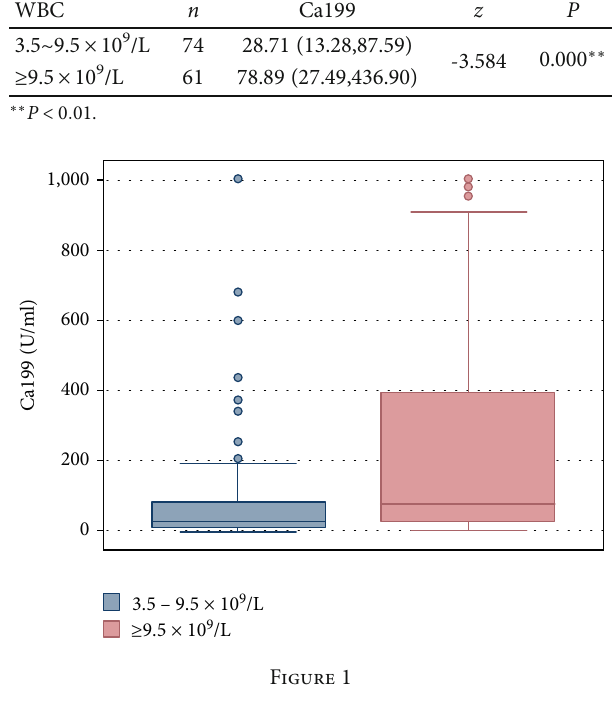
Table 3: Statistic result of